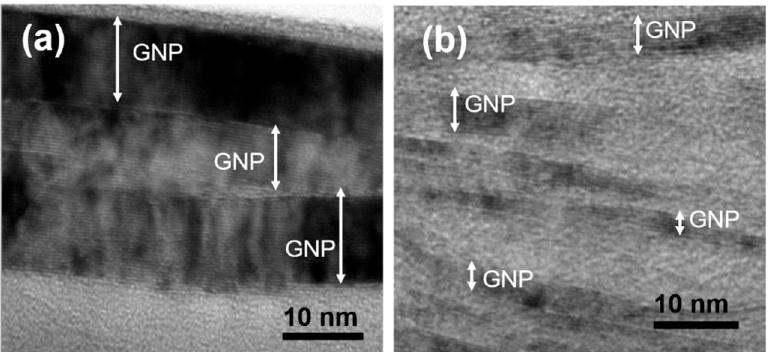
Figure 3. HR-TEM images of cross-sectional film’s platelets showing that they are composed by the superposition of graphite nanoplatelets (GNP). GNP can be well compacted ( a ), or quite separated ( b ) inside the platelets.